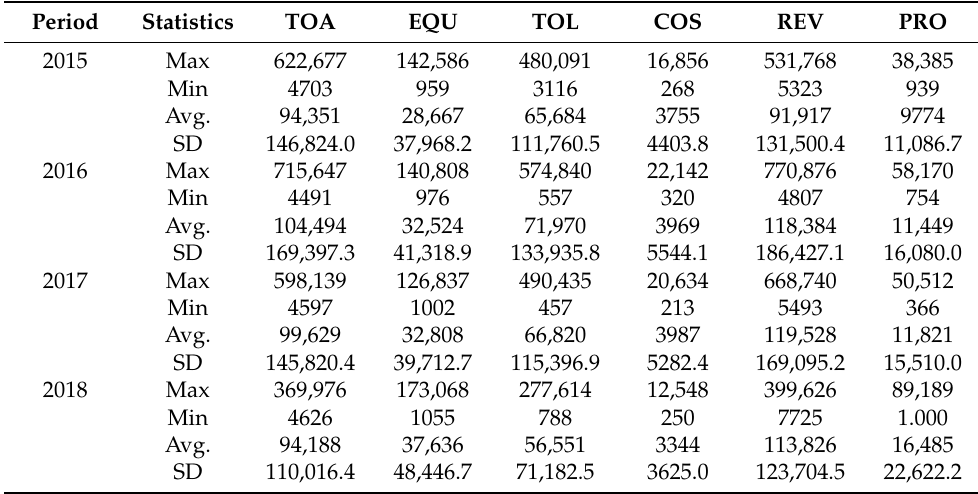
Table 4. The statistical data of input and output variables (unit: million